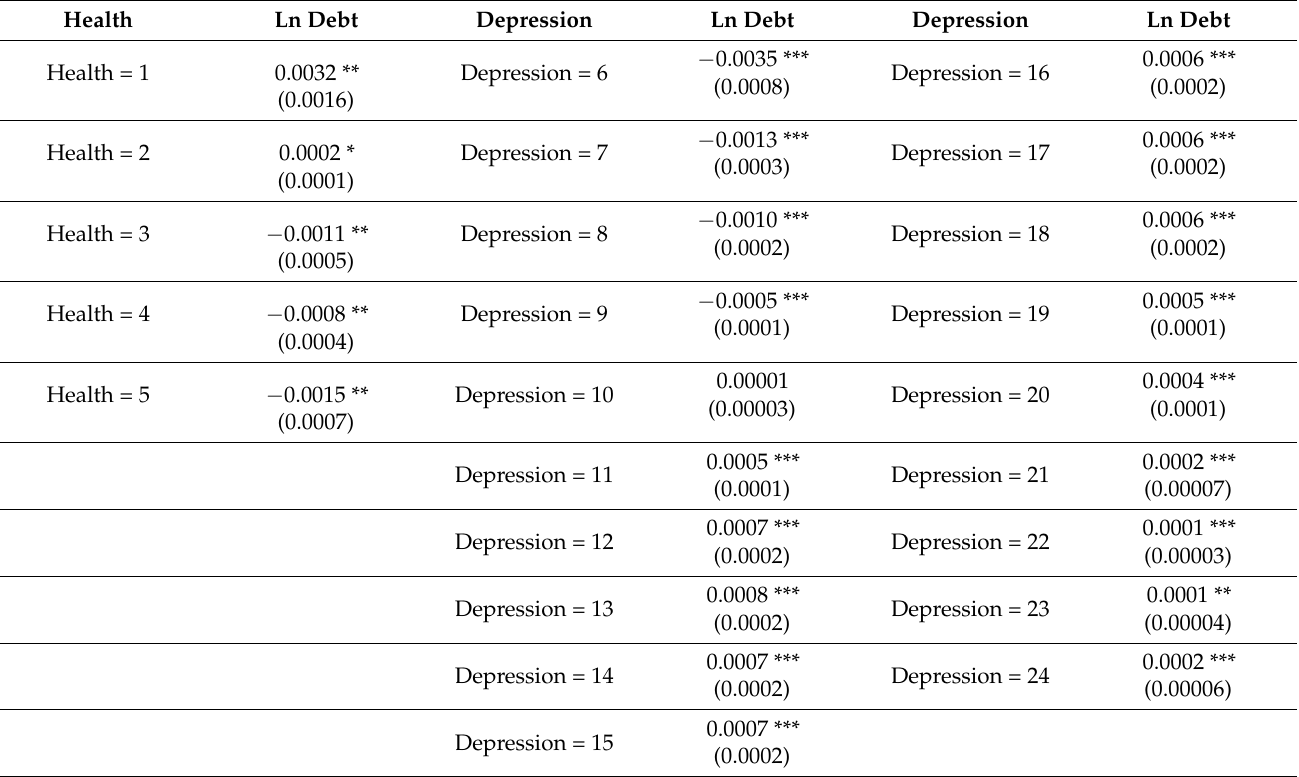
Table A3. Marginal effects of household debt in low education subgroup.